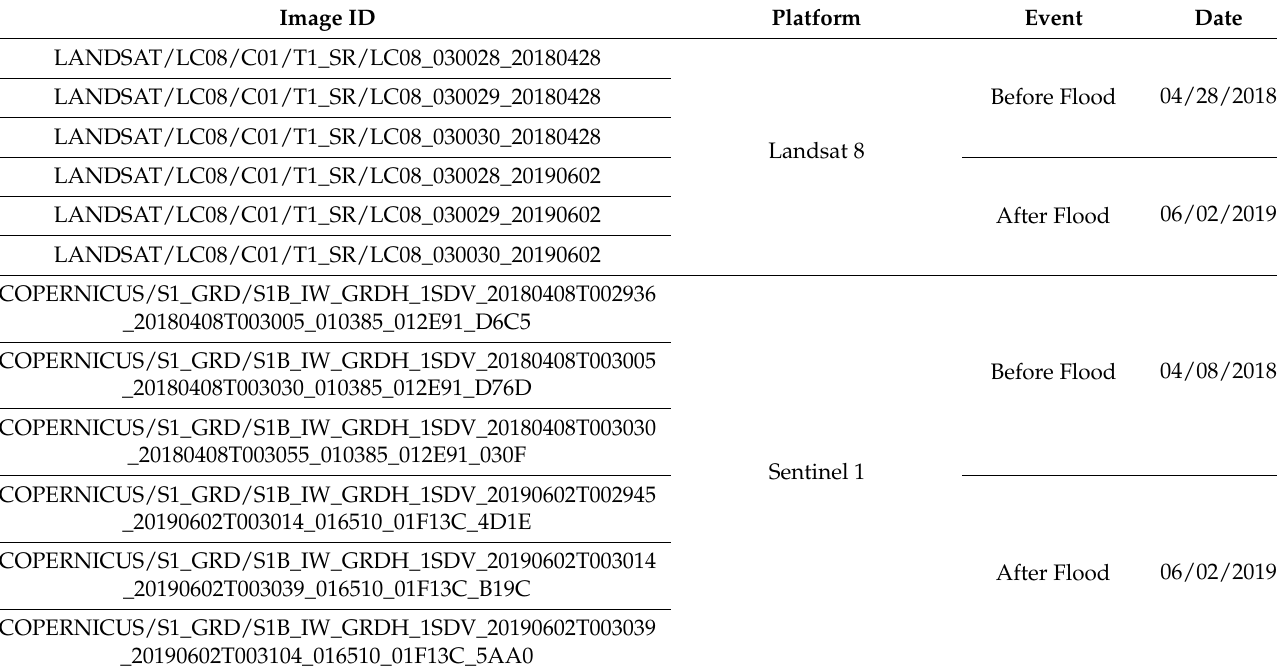
Table 2. Landsat Surface Reflectance and Ground Range Detected Sentinel Images used for this